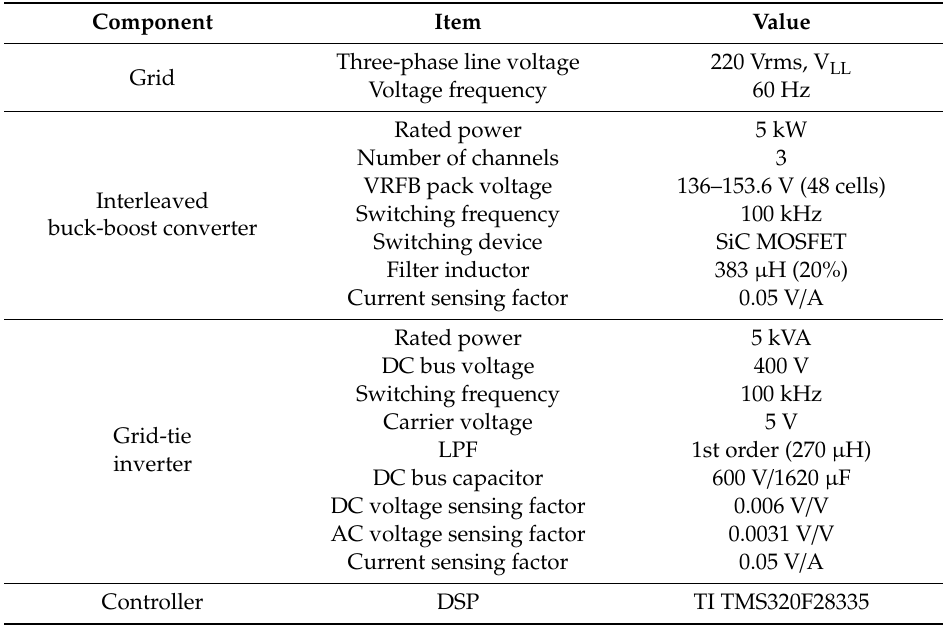
Table 1. Specifications of the proposed system.